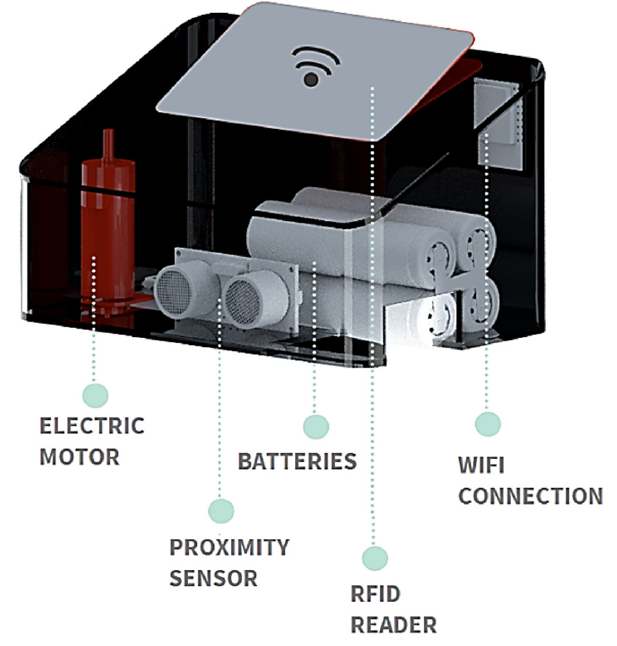
Figure 16. CAD 3D model.